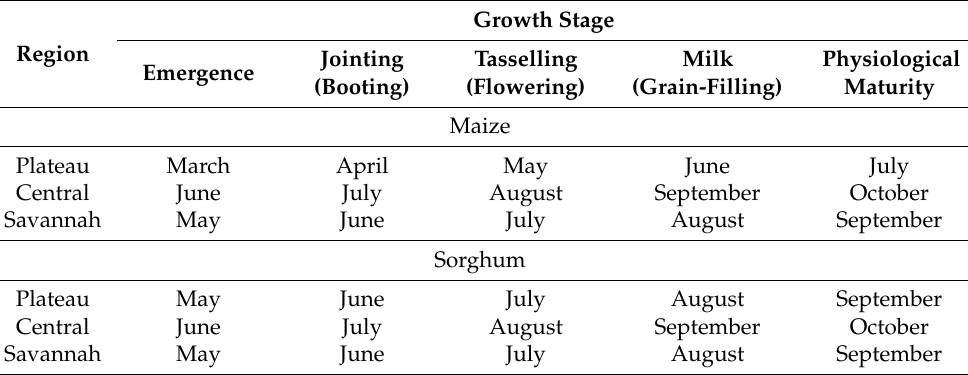
Figure 2. Average yields for maize ( a ) and sorghum ( b ) in Togo’s five administrative regions (1990–2019).